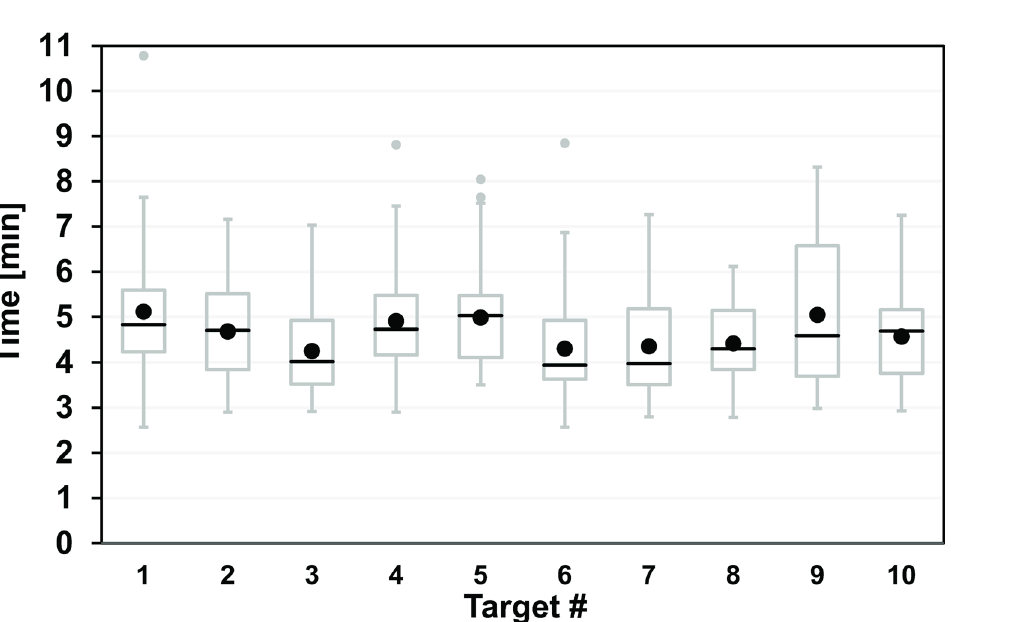
Fig 7. Experimental total biopsy times for 24 operators as a function of target number with variable target depth and ease of access. Each operator approached the targets #1 - #10 in the same order (see Fig 2 for details). Each box with whiskers represents the summary of 24 approaches of a single target by all operators (see Fig 5 for plot details). Four targets had 1 – 2 upper outliers (gray circles) with times greater than Q3 + 1.5 × IQR. The statistical differences in the biopsy time per target (black circles indicate mean) were not significant (p =